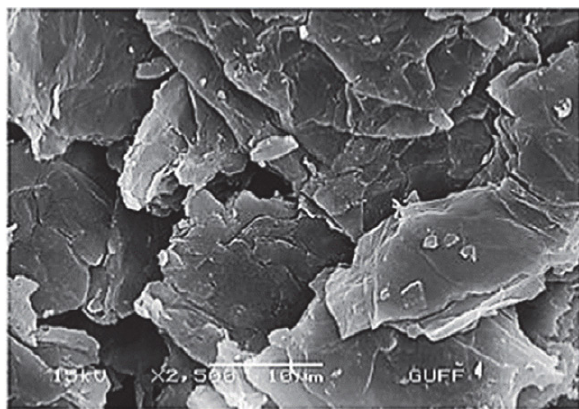
Figure 1. SEM images of synthesized graphene oxide .